Question: Give a one-sentence summary of this figure.
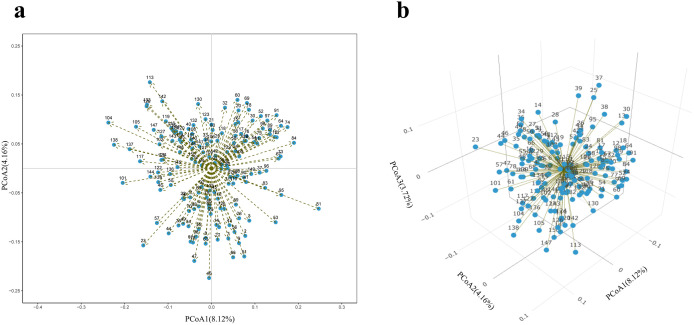
Answer: Principal Component Analysis. (a) Two-dimensional principal coordinate chart. (b) Three-dimensional principal coordinate chart. The first, second, and third principal coordinates explained 8.12%, 4.16%, and 3.72% of the total genetic variation, respectively.